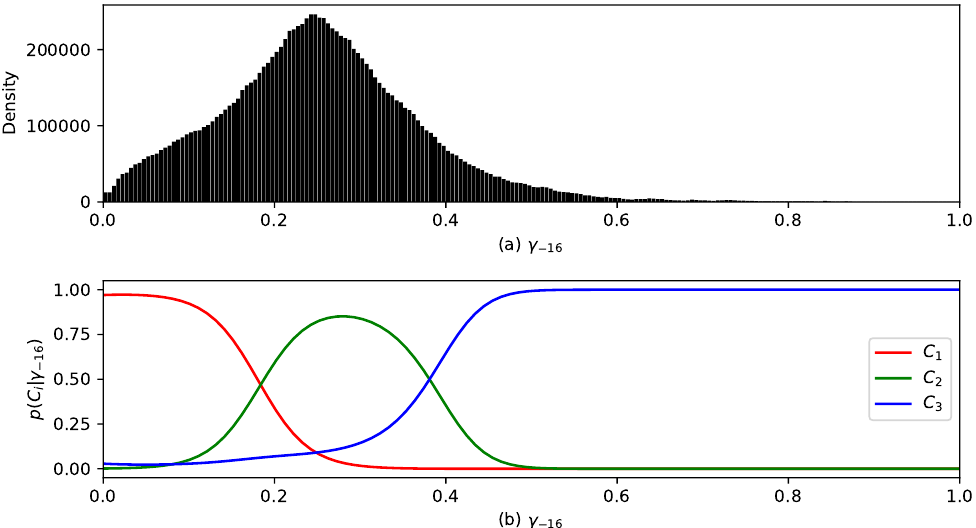
Figure 10. ( a ) Distribution of γ − 16 shown in Figure 9. ( b ) The conditional probabilities that a sample belongs to class C 1 (red line), C 2 (blue line), and C 3 (green line) resulted from the EM algorithm.